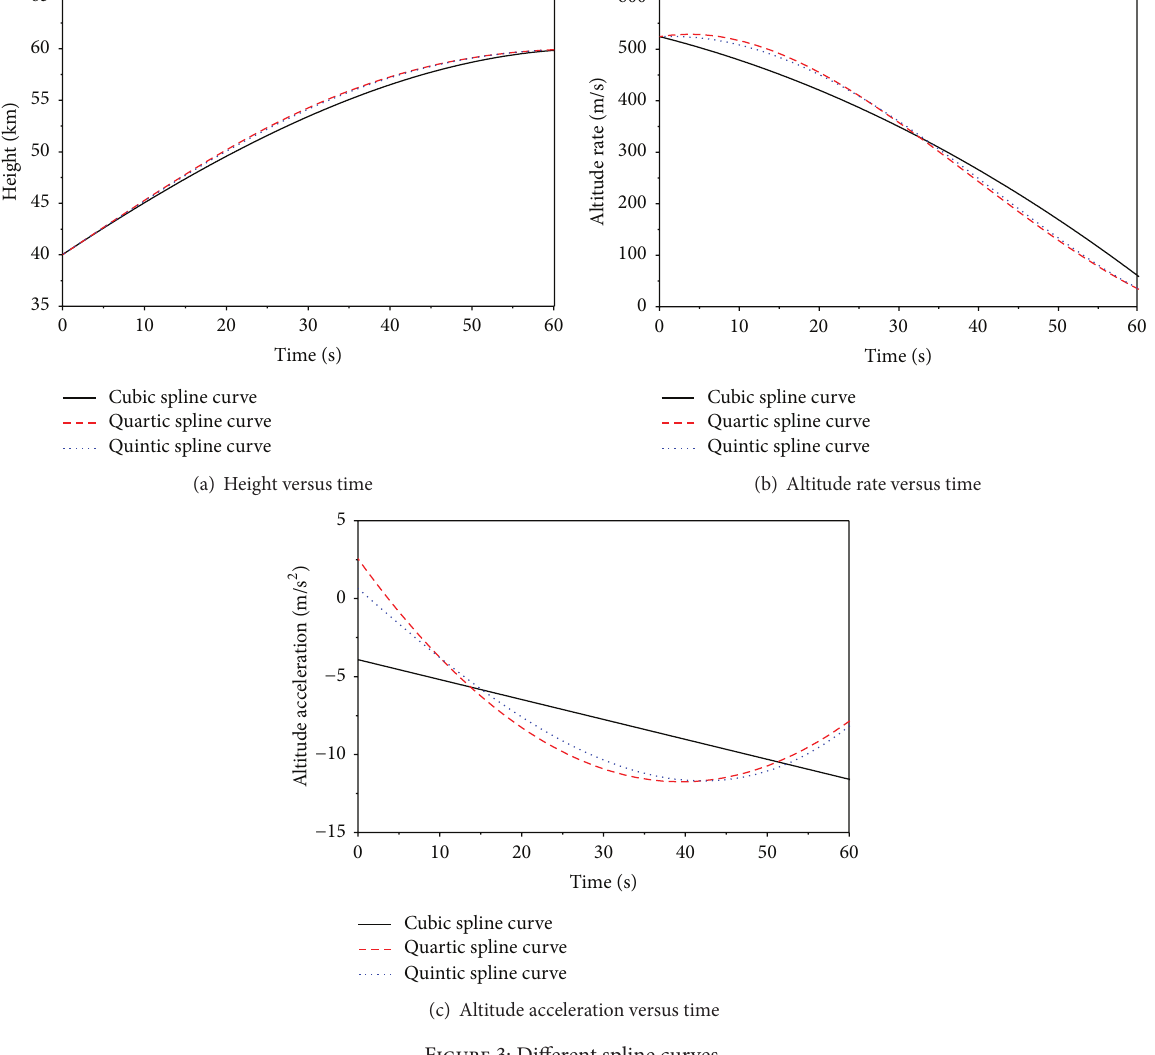
Figure 3: Different spline